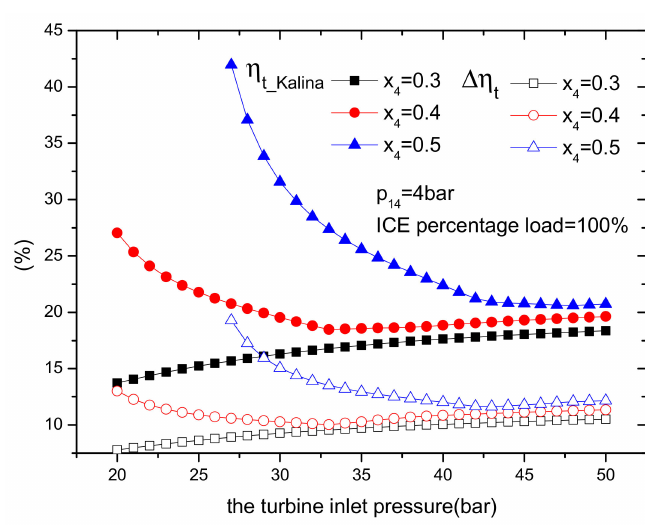
Figure 8. Effects of turbine inlet pressure on ∆ η t